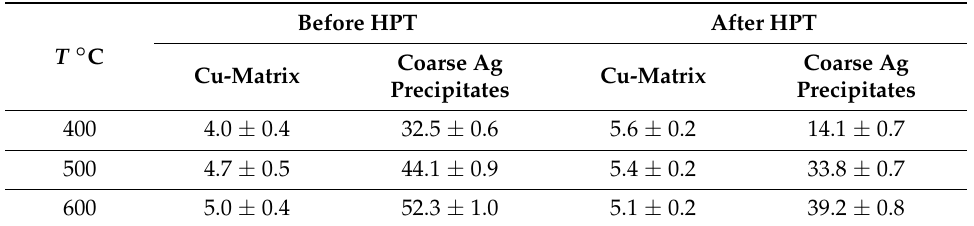
Table 2. Distribution of silver (wt.%) in the Cu–8wt.%Ag alloy before and after HPT process measured by